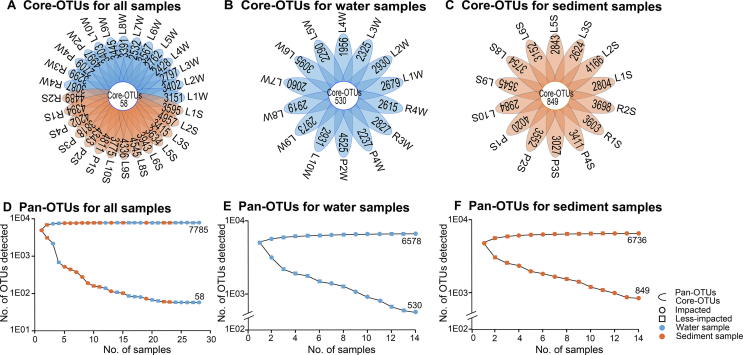
Core-OTUs and pan-OTUs of water and sediment samples from Honghu LakeFlower plots showing the number of sample-specific OTUs (in the petals) and core-OTUs (in the center) for all samples (A), all water samples (B), and all sediment samples (C). OTU accumulation curves for pan-OTUs (top) and core-OTUs (bottom) for all samples (D), all water samples (E), and all sediment samples (F), respectively, from Honghu Lake. Samples are named according to the sampling sites (see Figure 1B) with postfixes W and S for water and sediment, respectively.